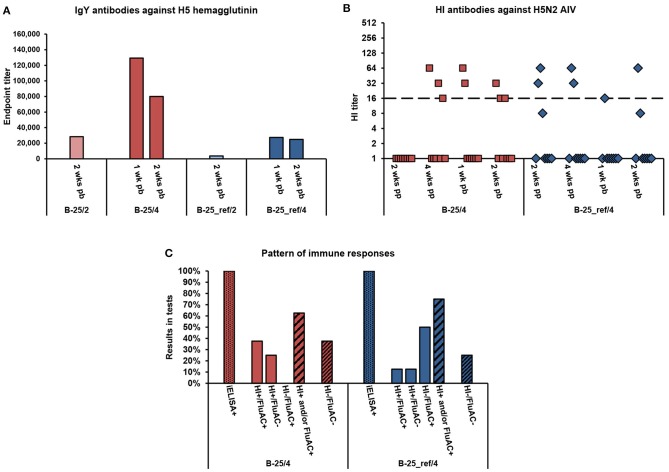
Serum antibody responses of broiler chickens to vaccination with alum-adjuvanted rH5-E. coli or rH5-BEVS. Four groups of 1-week-old broiler chickens (8 or 7 per group) in Exp 1 were vaccinated twice at 2- and 4-week intervals, with 25 μg of rH5-E. coli (B-25/2 and B-25/4) or rH5-BEVS (B-25_ref/2 and B-25_ref/4) and aluminum hydroxide (alum) adjuvant. Sera collected post-prime (pp) and/or post-boost (pb) were analyzed for the presence of anti-H5 HA antibodies using the indirect and competitive ELISAs, H5 iELISA and FluAC H5, respectively, and a hemagglutination inhibition (HI) assay with H5N2 low-pathogenic (LP) AIV. Tests were performed and interpreted as described in the Materials and Methods section. In (A), the results for all of the test vaccine groups are presented. In (B,C), only the results for chickens vaccinated at a 4-week interval are shown. The chickens vaccinated at a 2-week interval were seronegative in relevant tests (Table 3). (A) Endpoint titers of anti-H5 HA IgY antibodies in post-boost sera. Each bar represents the result for the pooled sera collected from one group of chickens at the indicated time point. (B) Titers of HI antibodies against H5N2 LPAIV in post-prime and post-boost sera. Each symbol represents the result for one chicken at the specified time point. A value of 1.0 indicates that the HI antibody titer was below the detection limit (1:8). The dashed line indicates the cut-off value in the HI test (1:16). (C) Pattern of immune responses to the prime-boost vaccination. Considering the results from all of the post-vaccination sera, chickens were classified as positive (+) or negative (–) in H5 iELISAs (iELISA) or HI and FluAC H5 tests (HI/FluAC). Each bar represents a percentage of the specified category of chickens in each group.